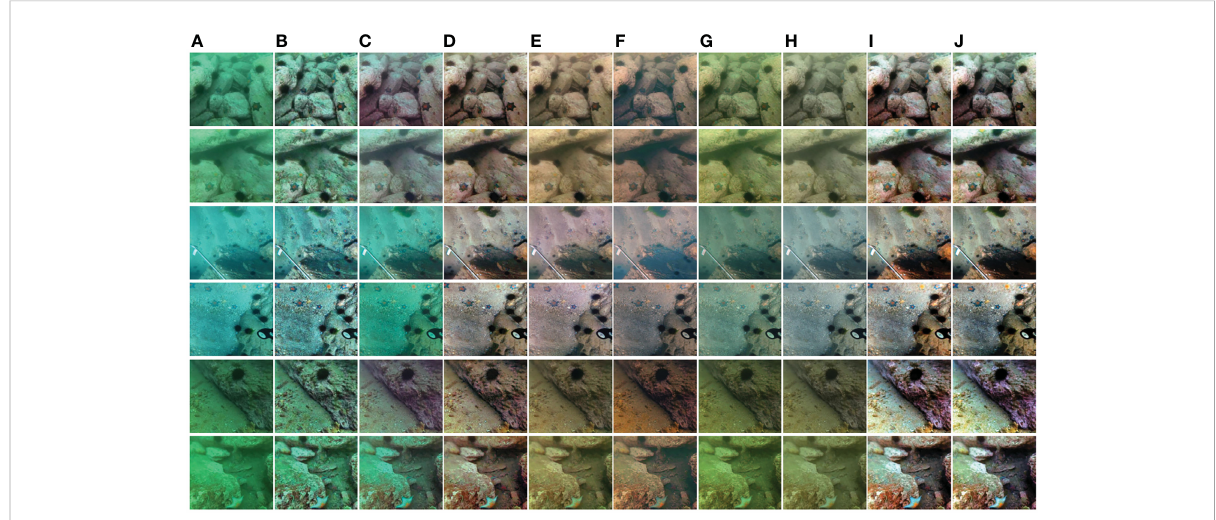
FIGURE 7 Visual comparisons on the UCCS subset of the RUIE dataset. From left to right, (A) shows the raw underwater images, (B – J) are the results of CLAHE (Pizer et al., 1990), OMGD (Ren et al., 2021), UGAN-P (Fabbri et al., 2018), FUnIE-GAN (Islam et al., 2020), WaterNet (Li et al., 2019), UWCNN (Li et al., 2020), Shallow-UWnet (Naik et al., 2021), Spiral-GAN (Han et al., 2020) and the proposed model,